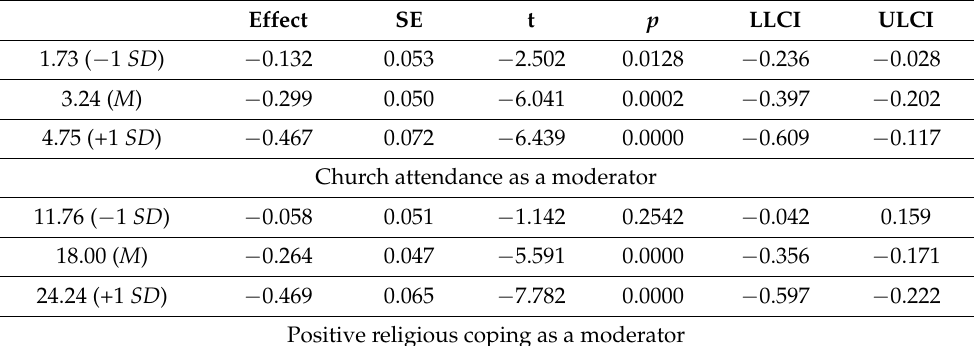
Table 8. Conditional effects of tendency to avoid transgressor at values of